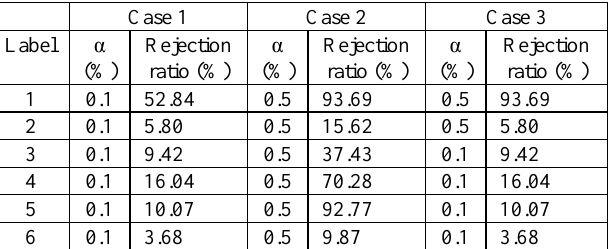
Table 5. The ratio of rejected DEM points in each case